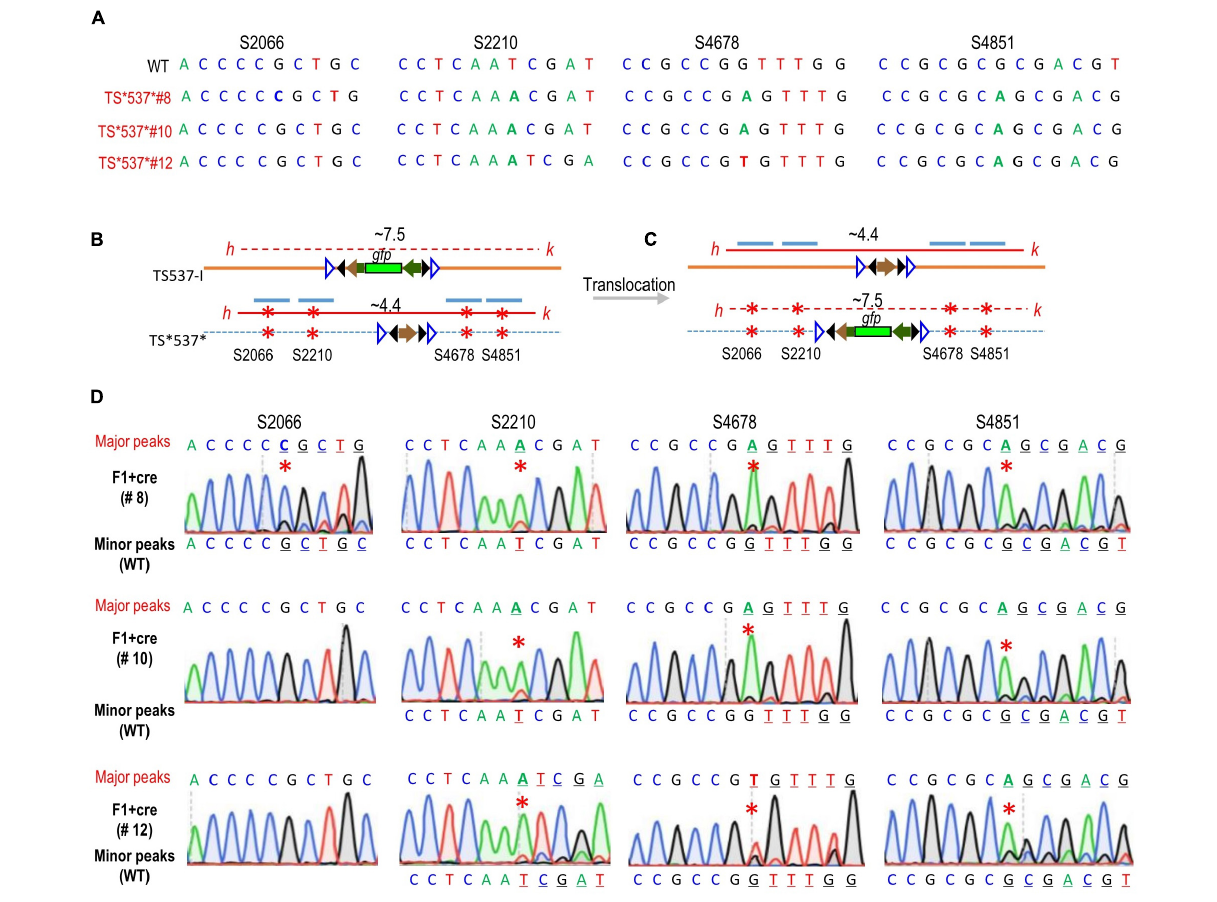
FIGURE 3 | Sequencing results after gene exchange between allelic target sites. (A) Sequences of regions corresponding to CRISPR mutation sites. PCR product h–k containing gfp before (B) or after translocation (C) was too long ( ∼ 7.5 kb) for amplification (dashed red line) in competing reaction with shorter ( ∼ 4.4 kb) attP fragment (solid red line) without gfp . Blue lines depict the four regions sequenced, respectively. (D) Sequencing data from the ∼ 4.4 kb h–k fragments from different F1 + cre genomes. Major peaks consistent with the TS*537*-derived sequence before translocation (B) ; minor peaks consistent with the TS537-derived sequence after translocation (C) . Red * indicates CRISPR